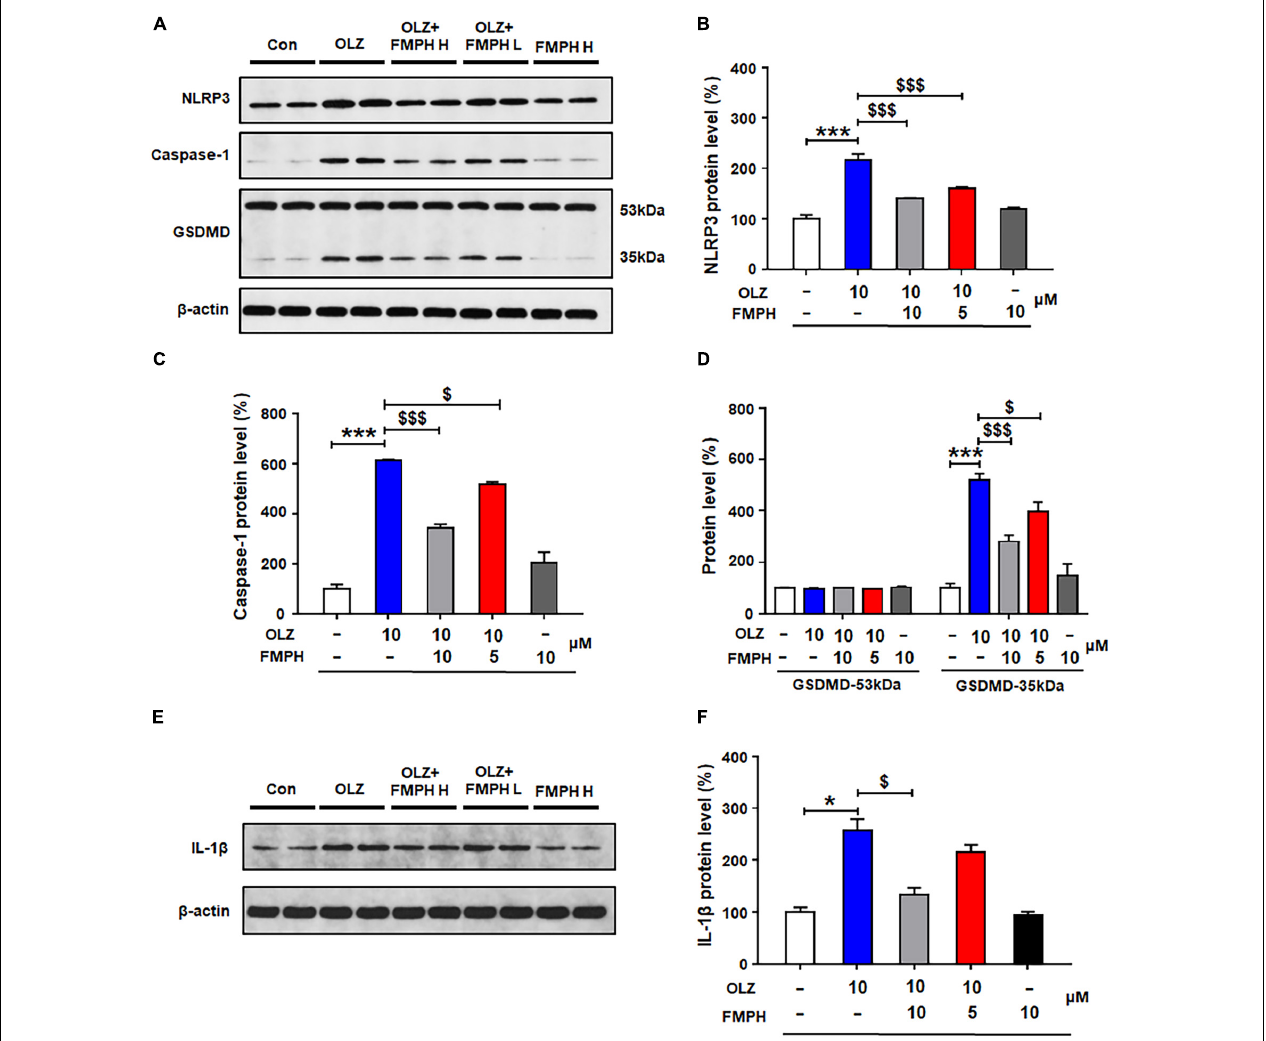
FIGURE 6 | 2-(3-Trifluoromethylphenyl) histamine (FMPH) co-treatment inhibited olanzapine-induced NLRP3/caspase-1 signaling activation and reduced IL-1 β protein expression in cultured astrocytes. (A–F) Cultured cells were treated with vehicle [dimethyl sulfoxide (DMSO) + water], olanzapine 10 µ M, olanzapine 10 µ M + FMPH 10 µ M, olanzapine 10 µ M + FMPH 5 µ M, or FMPH 10 µ M for 24 h. Western blot was used to examine the expression of NLRP3, caspase-1 (20 kDa), GSDMD (53 and 35 kDa), and IL-1 β . The data are presented as the mean ± standard error of the mean. * p < 0.05, *** p < 0.001 vs. Con; $ p <